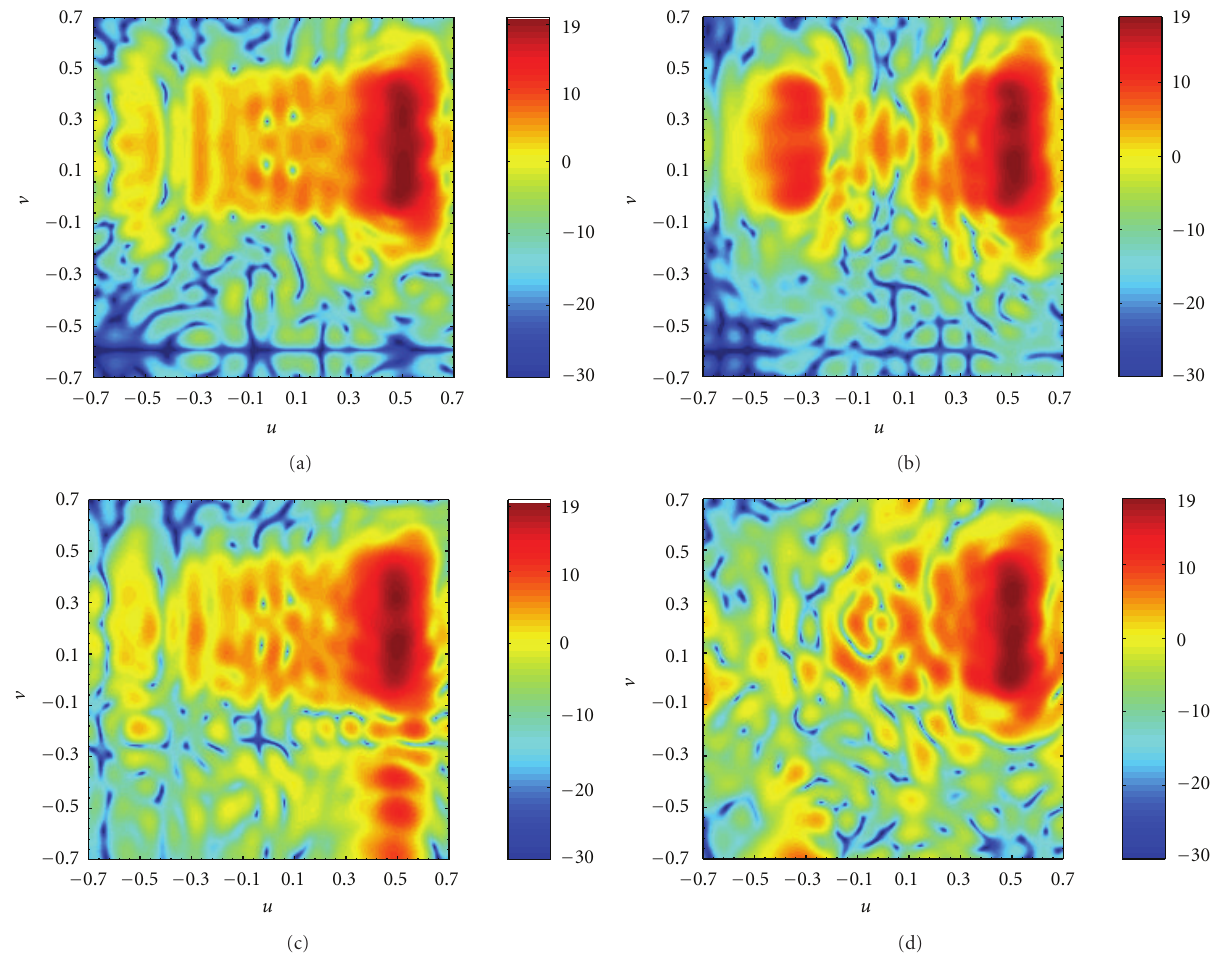
Figure 8: Radiation patterns produced with the shaped-beam reflectarray antenna using di ff erent lattices. (a) Without any grouping. (b) Grouping along the x -axis. (c) Grouping along the y -axis. (d) Grouping in an irregular lattice.